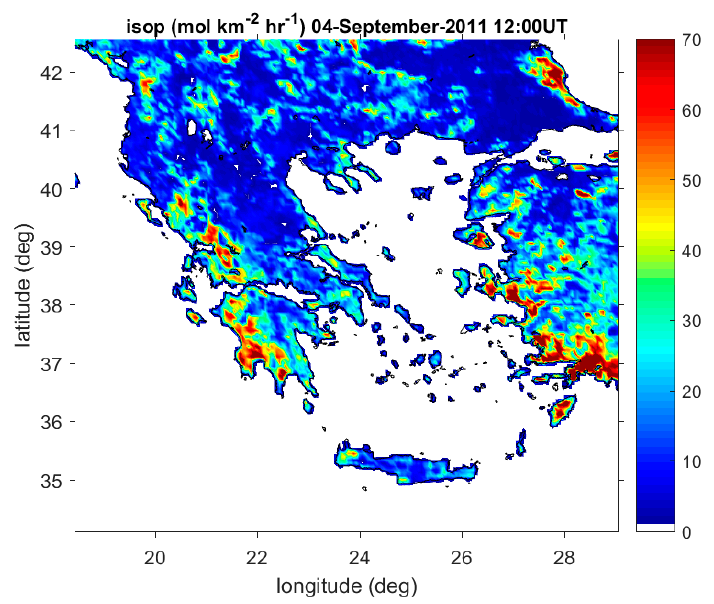
Figure 7. Isoprene emissions over Greece at 12:00 UT (results from [21]). Table 3. Comparison between the hourly isoprene emissions derived from [21] (MEGAN) and from the present work concerning the month of September.